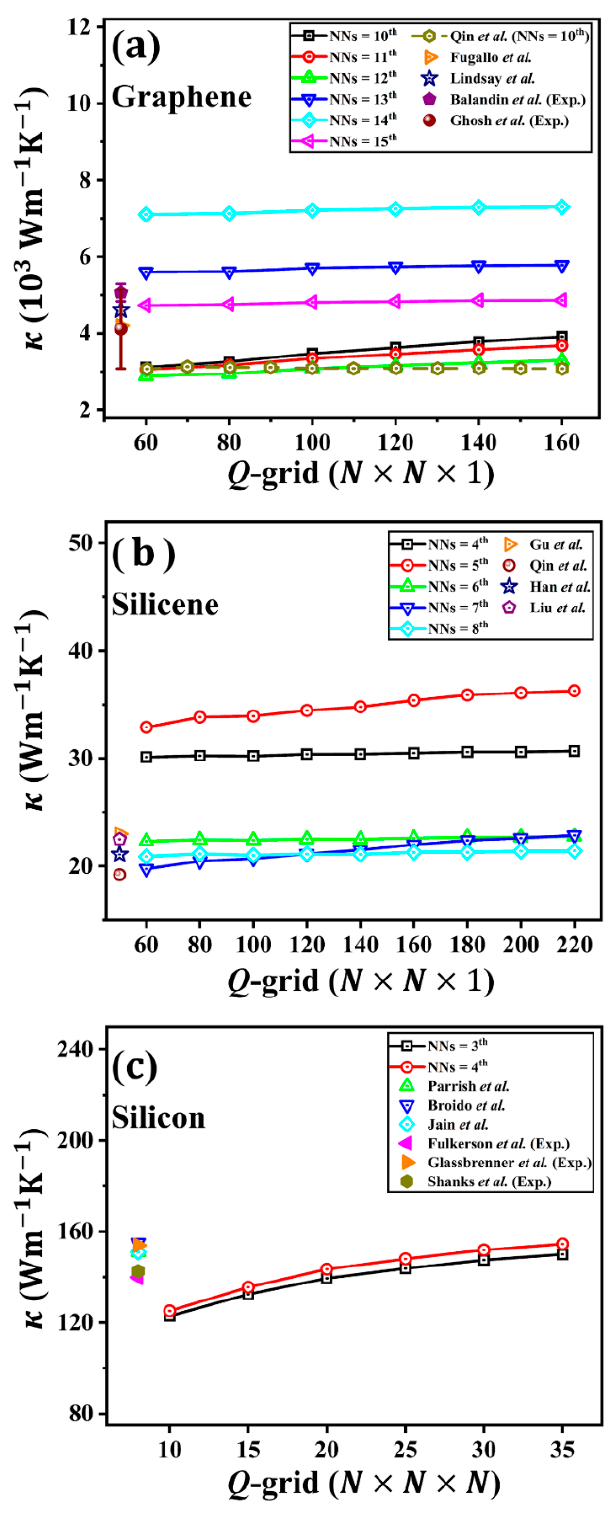
Figure 2. The room temperature thermal conductivity κ with respect to the Q -grid for different nearest neighbors (NNs). ( a ) Graphene. The literature results were adapted from Qin et al. [40], Fugallo et al. [62], Lindsay et al. [63], Balandin et al. [4], and Ghosh et al. [64]. ( b ) Silicene. The literature results were adapted from Gu et al. [65], Qin et al. [66], Han et al. [67], and Liu et al. [68]. ( c ) Bulk silicon. The literature results were adapted from Parrish et al. [69], Broido et al. [70], Jain et al. [39], Fulkerson et al. [71], Glassbrenner et al. [72], and Shanks et al.